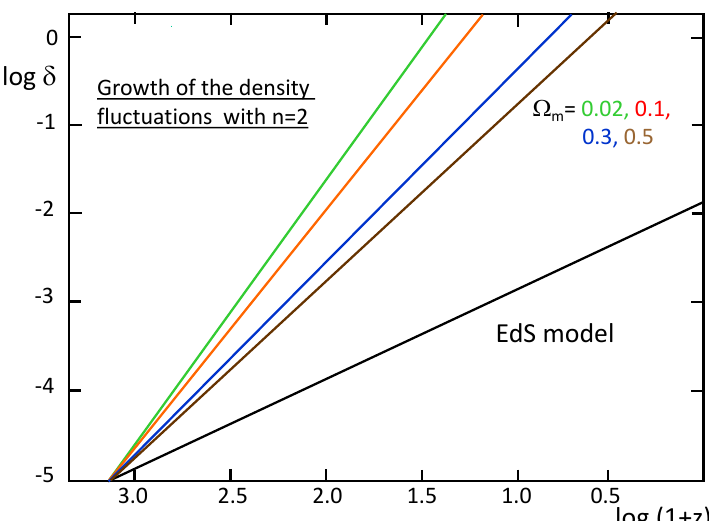
Figure 11. The growth of density fluctuations for different values of parameter Ω m for n = 2. The values δ = 1 are reached in the interval of redshifts ( z + 1 ) = 4.0 to 29.3. From